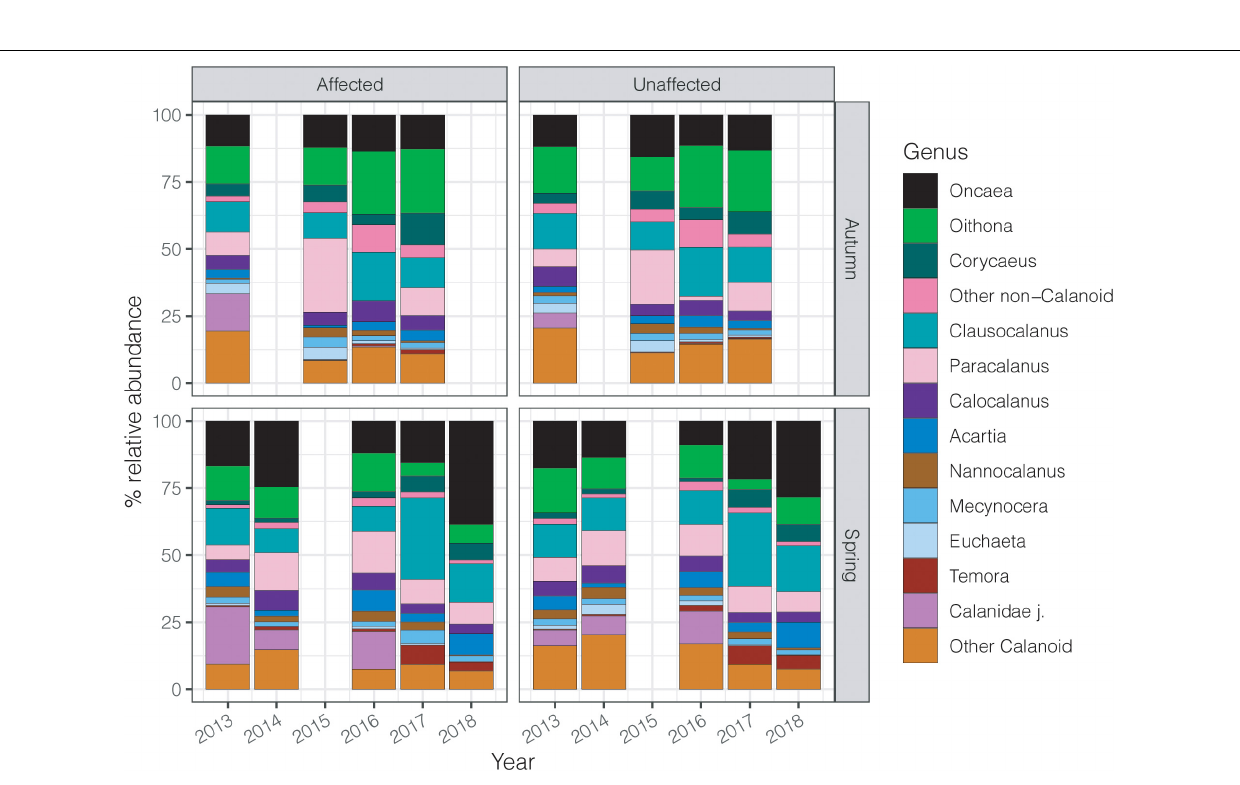
Frontiers in Marine Science |